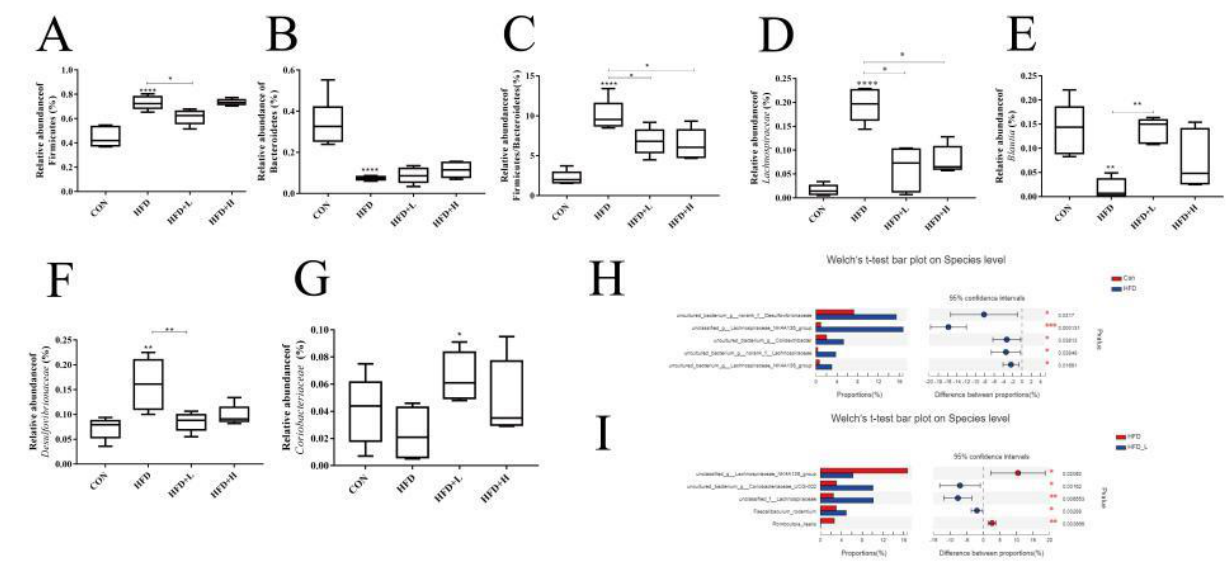
Figure 9. CIP improved the composition of intestinal flora in HFD-fed mice. ( A ) Relative abundance of Firmicutes; ( B ) relative abundance of Bacteroidetes; ( C ) relative abundance ratio of Firmicutes to Bacteroidetes; ( D – G ) abundance of intestinal bacteria in mice (( D ), Lachnospiraceae; ( E ), Blautia ; ( F ), Desulfovibrionaceae ; ( G ), Coriobacteriaceae ); ( H ) species-level correlation of microbiota between the HFD group and CON group; ( I ) species-level correlation of microbiota between the HFD group and HFD+L group. Data ( n = 5) were shown as mean ± SEM. * p < 0.05, ** p < 0.005, and **** p < 0.0001 compared with the other groups.